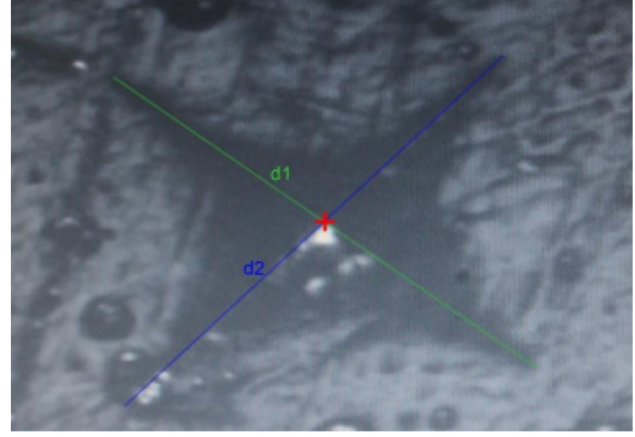
Figure 1. Microscopic image of the impression left by the pyramidal indenter during the Vickers hardness test with markings of diagonals d 1 and d 2 .